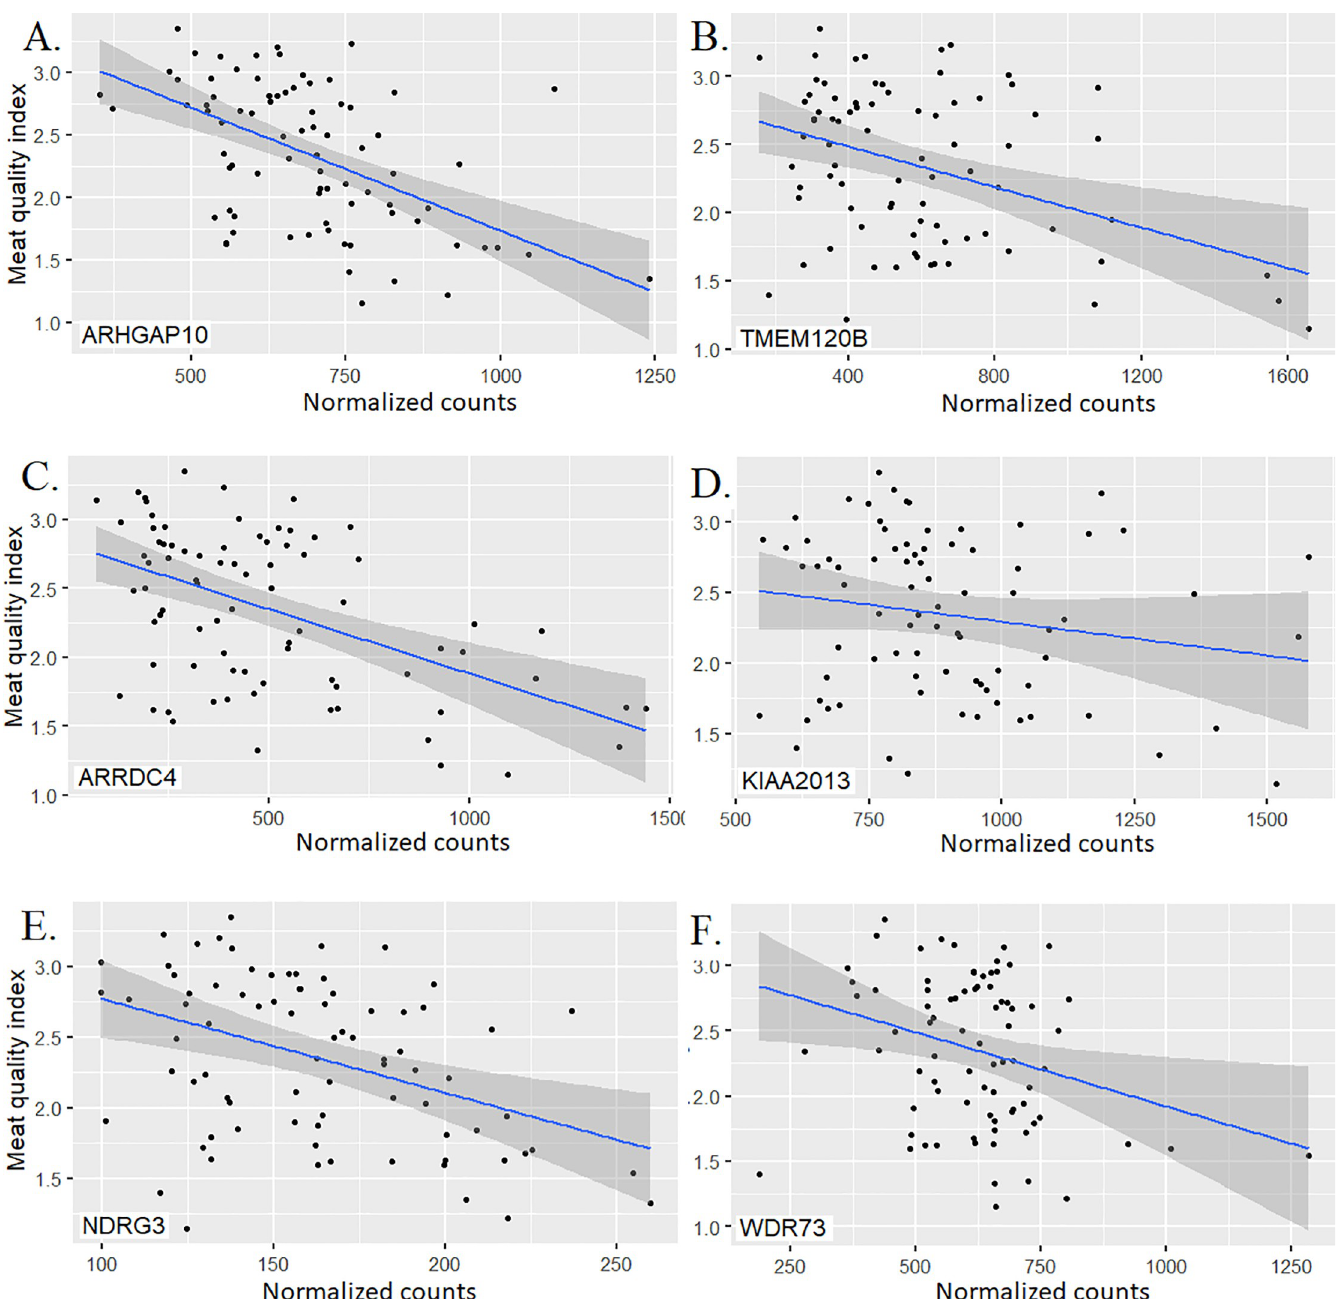
Fig 4. Scatter plots with regression lines and 95% confidence intervals for gene normalized counts and meat quality index for the top six associated genes. The meat quality index was constructed using observed phenotypes measured in longissimus dorsi muscle from a multibreed Angus-Brahman population.